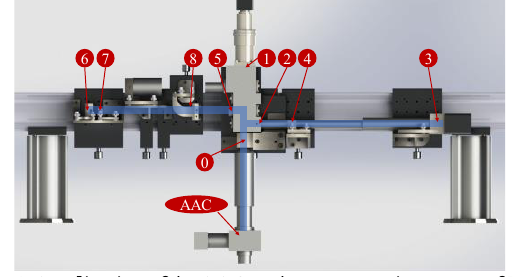
Fig. 1. Application of the AAC at the custom microscope of